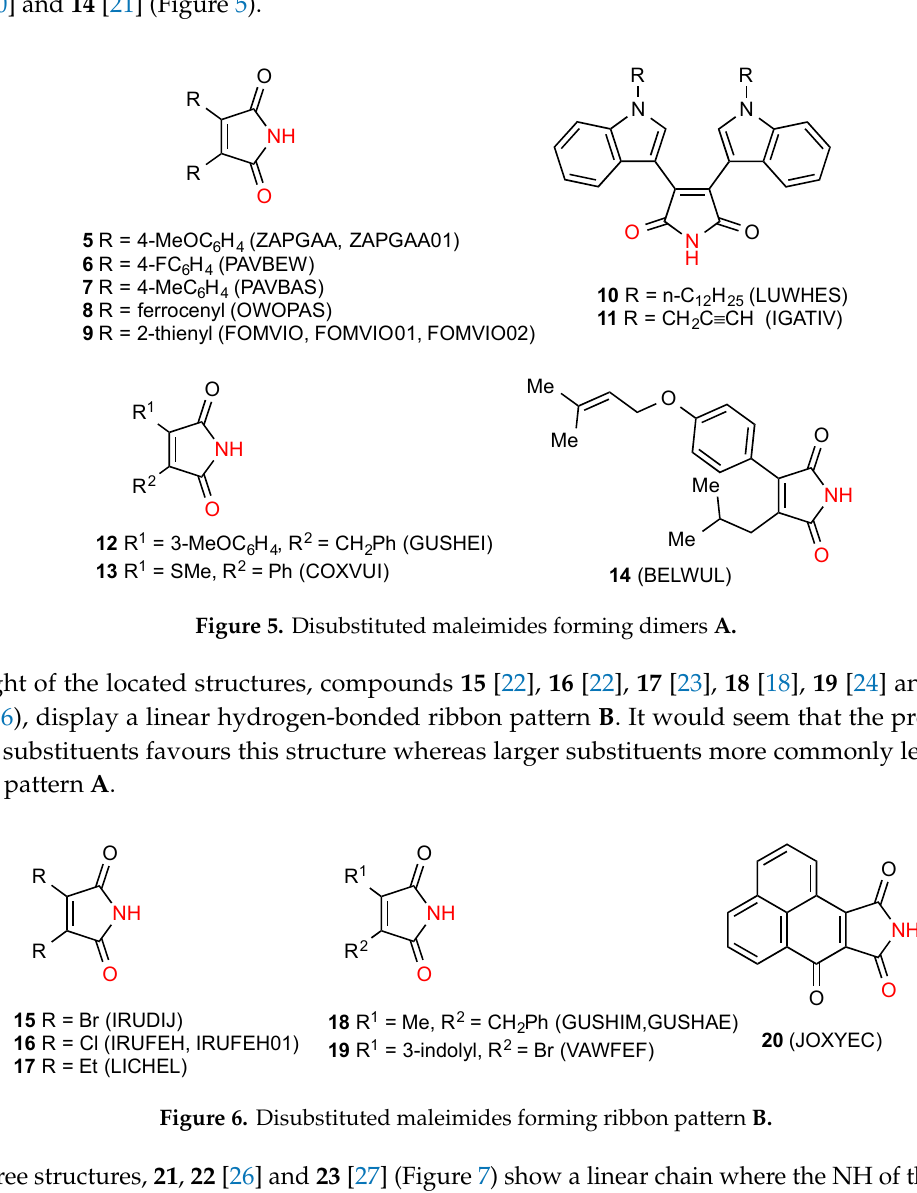
Figure 7. Disubstituted maleimides showing NH bonding to remote O or N acceptors.